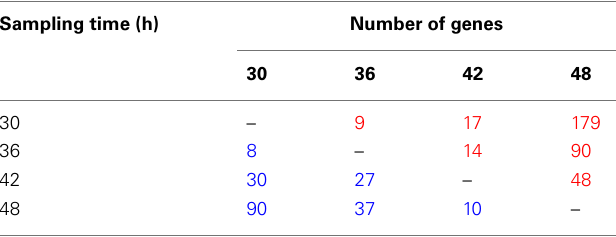
Table 3 | Number of altered genes with fold change in the rat UESCs as revealed by microarray